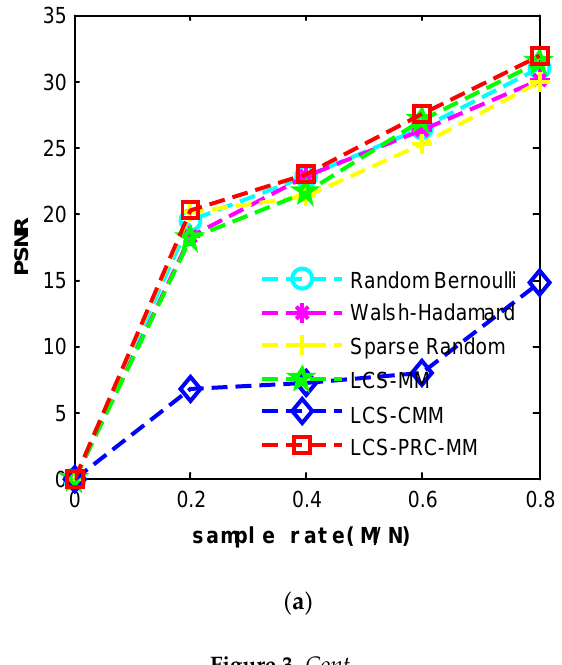
( b ) ( c ) Figure 3. Comparison of reconstruction of the target image with the TVAL3 recovery algorithm under different measurement matrices: ( a ) analysis of reconstruction results by using peak signal-to-noise ratio (PSNR), ( b ) analysis on reconstruction results by using structural similarity (SSIM), and ( c ) target image.